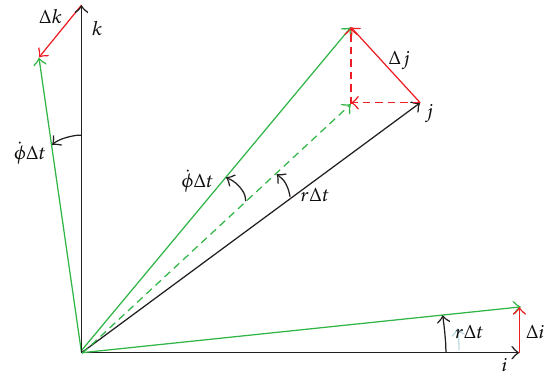
Figure 7: The change of the 𝑥 - 𝑦 - 𝑧 coordinate system.